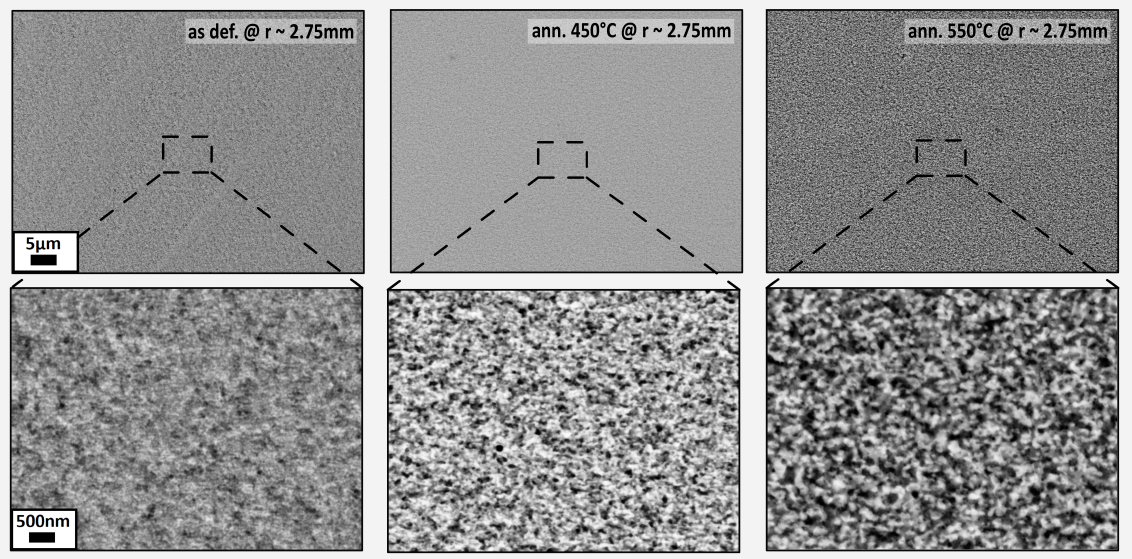
Figure 5. SEM micrographs were done in BSE mode of as-deformed and annealed samples of the Fe 10 Ni 40 NiO 50 composition. The annealing initiated a phase growth and change of interface morphology for the samples annealed at 450 °C and 550 °C. The micron bar applies to all micrographs in the same